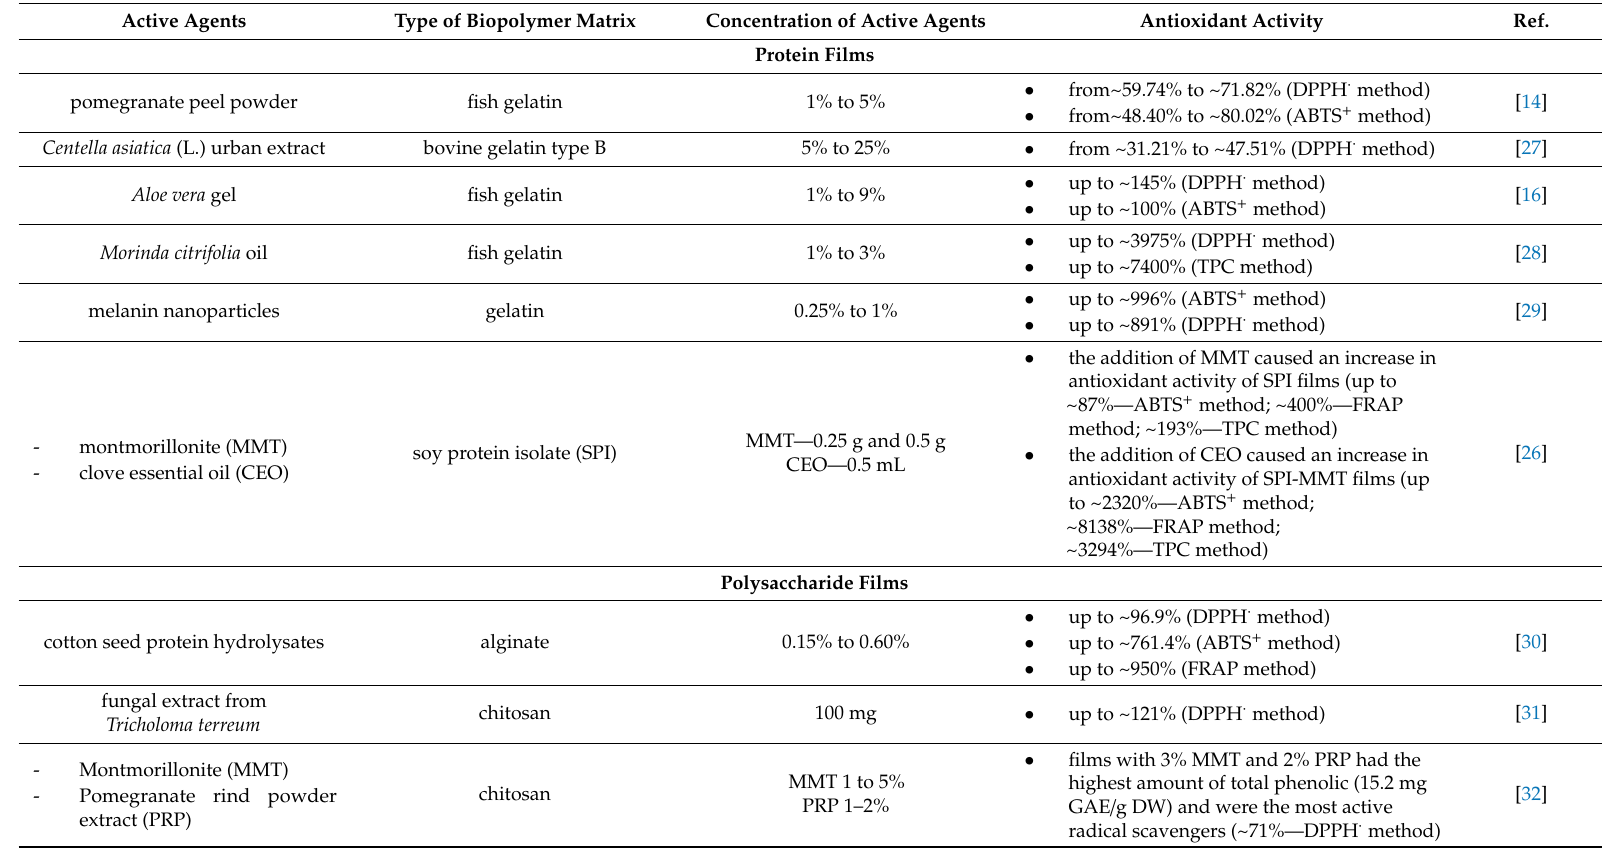
Table 1. Recent studies on biopolymer films with antioxidant